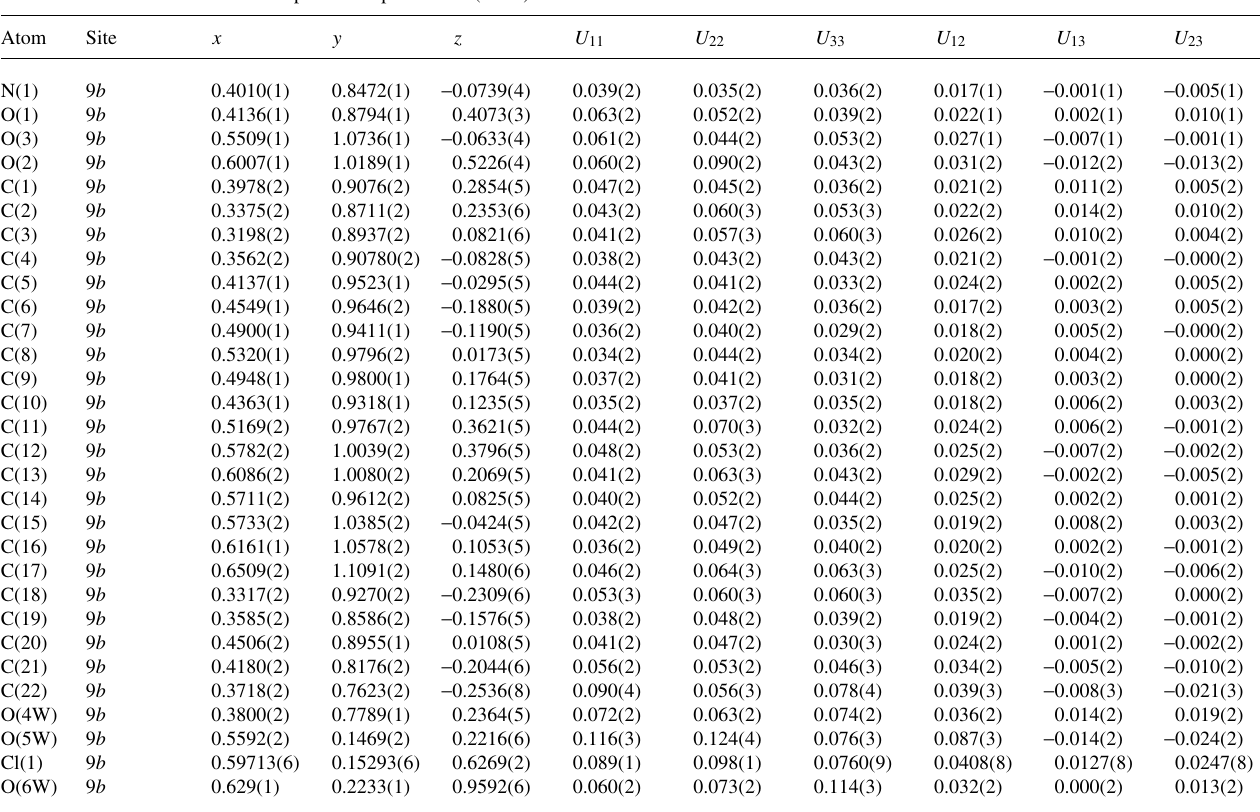
Table 3. Atomic coordinates and displacement parameters (in Å 2 )